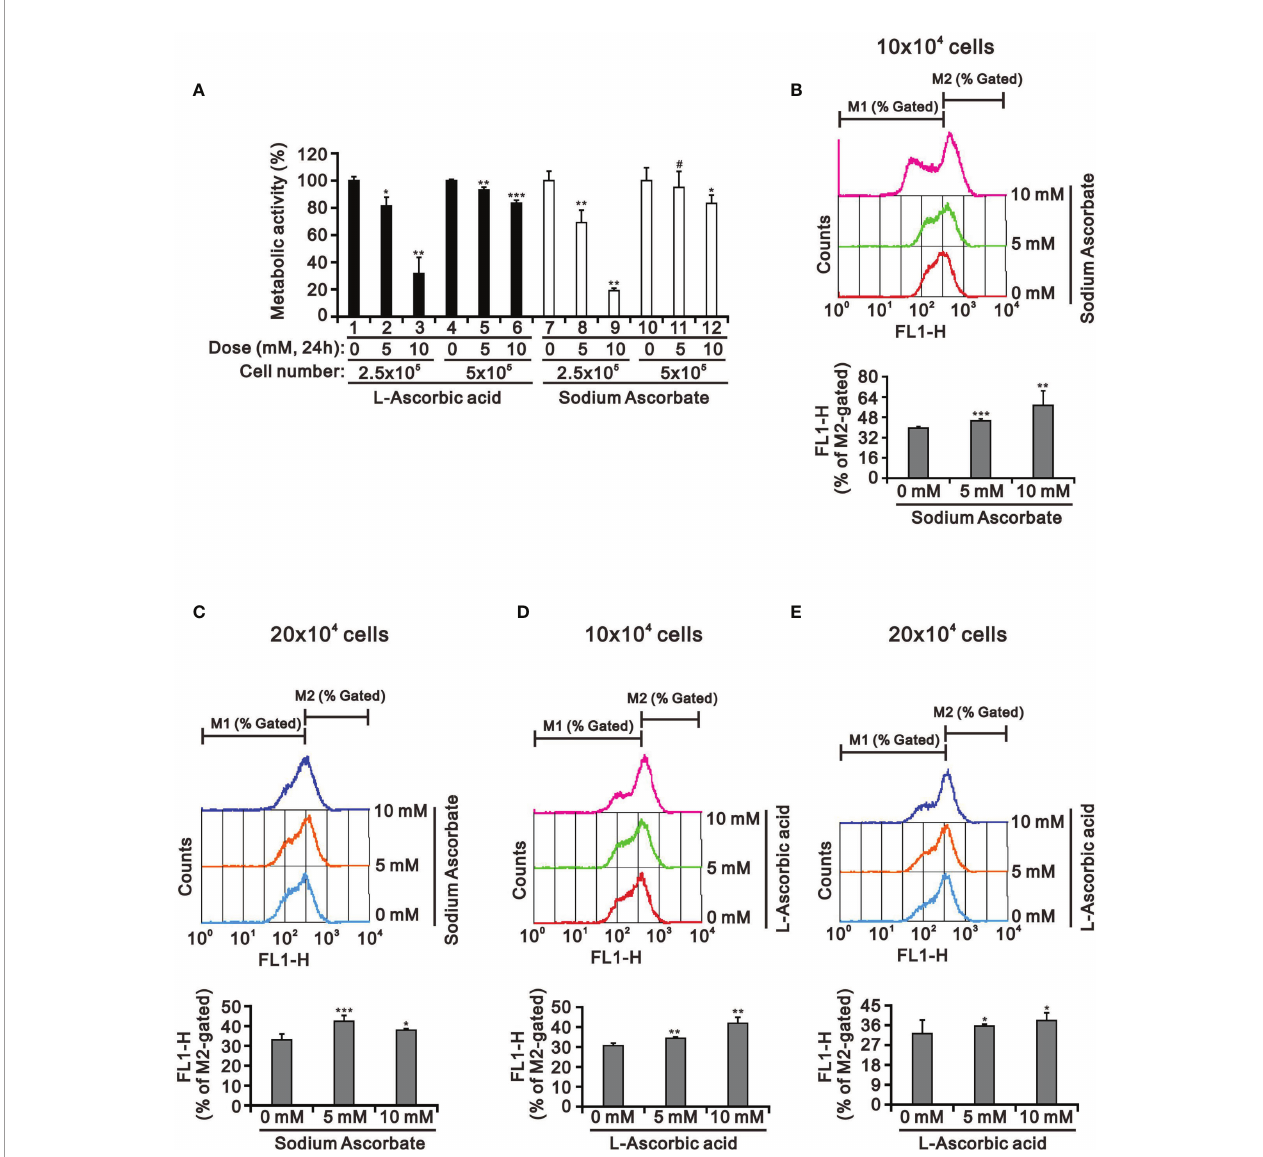
FIGURE 3 | The cell density effect on cell metabolic activity and mitochondrial membrane potential in HepG2 cells. The two indicated cell densities of HepG2 cells were treated with 5 mM or 10 mM L -AA (or sodium ascorbate) for 24 h, after which their cell lysates were investigated for their (A) cell metabolic activity using the MTT assay and (B – E) mitochondrial membrane potential using a fl ow cytometer. The cell volume gating strategy involved FSC-H and SSC-H, and the median fl uorescence intensity of the vehicle was used as the starting point for M2 gating. We show one representative result. Bars depict the mean ± SD of three independent experiments. # p > 0.05, * p < 0.05, ** p < 0.01, and *** p < 0.001 compared with the vehicle (Student ’ s